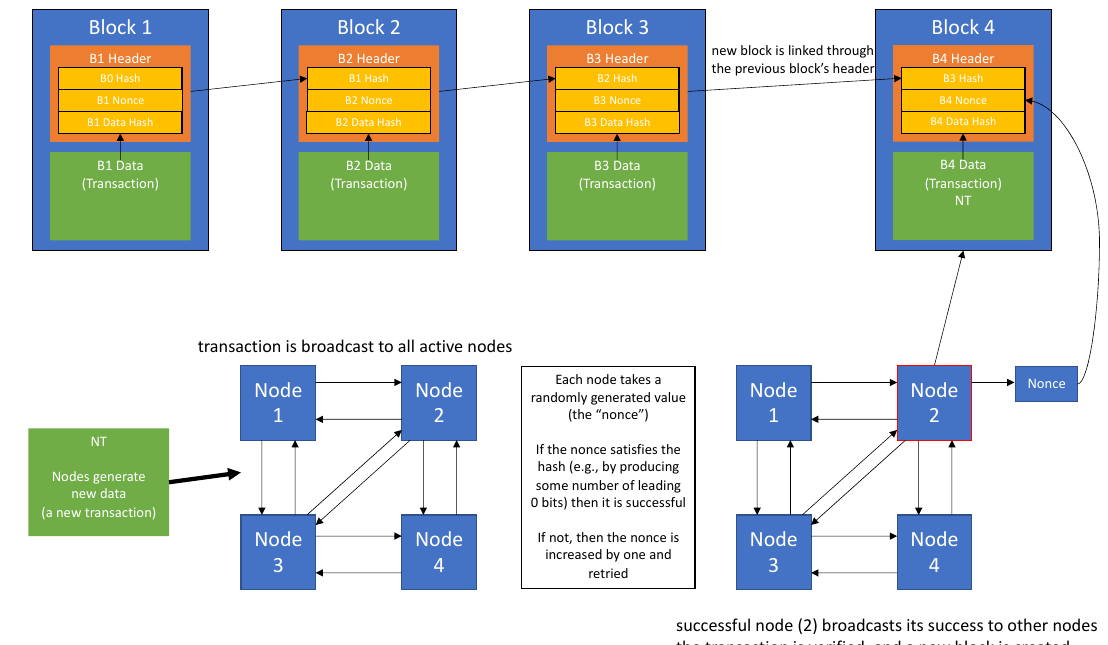
Figure 2. Summary of basic blockchain methodology. When transactions are made that need to be stored in the chain. nodes compete to find a “nonce” that satisfies the hash-problem assigned to them. If the data is valid, the successful node creates a block, which is chained to the most recently created block in the longest chain.